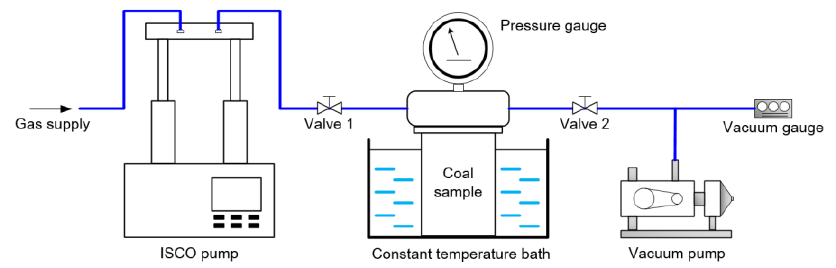
Figure 2. Schematic diagram showing the set-up used for the supercritical CO 2 treatments.